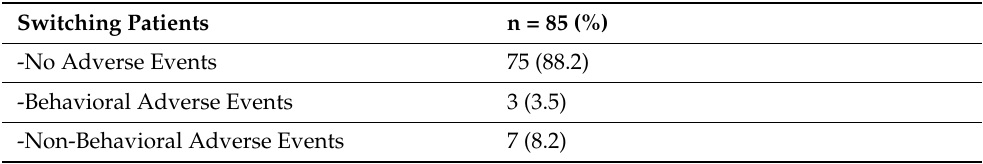
Table 6. Adverse events in patients switching from